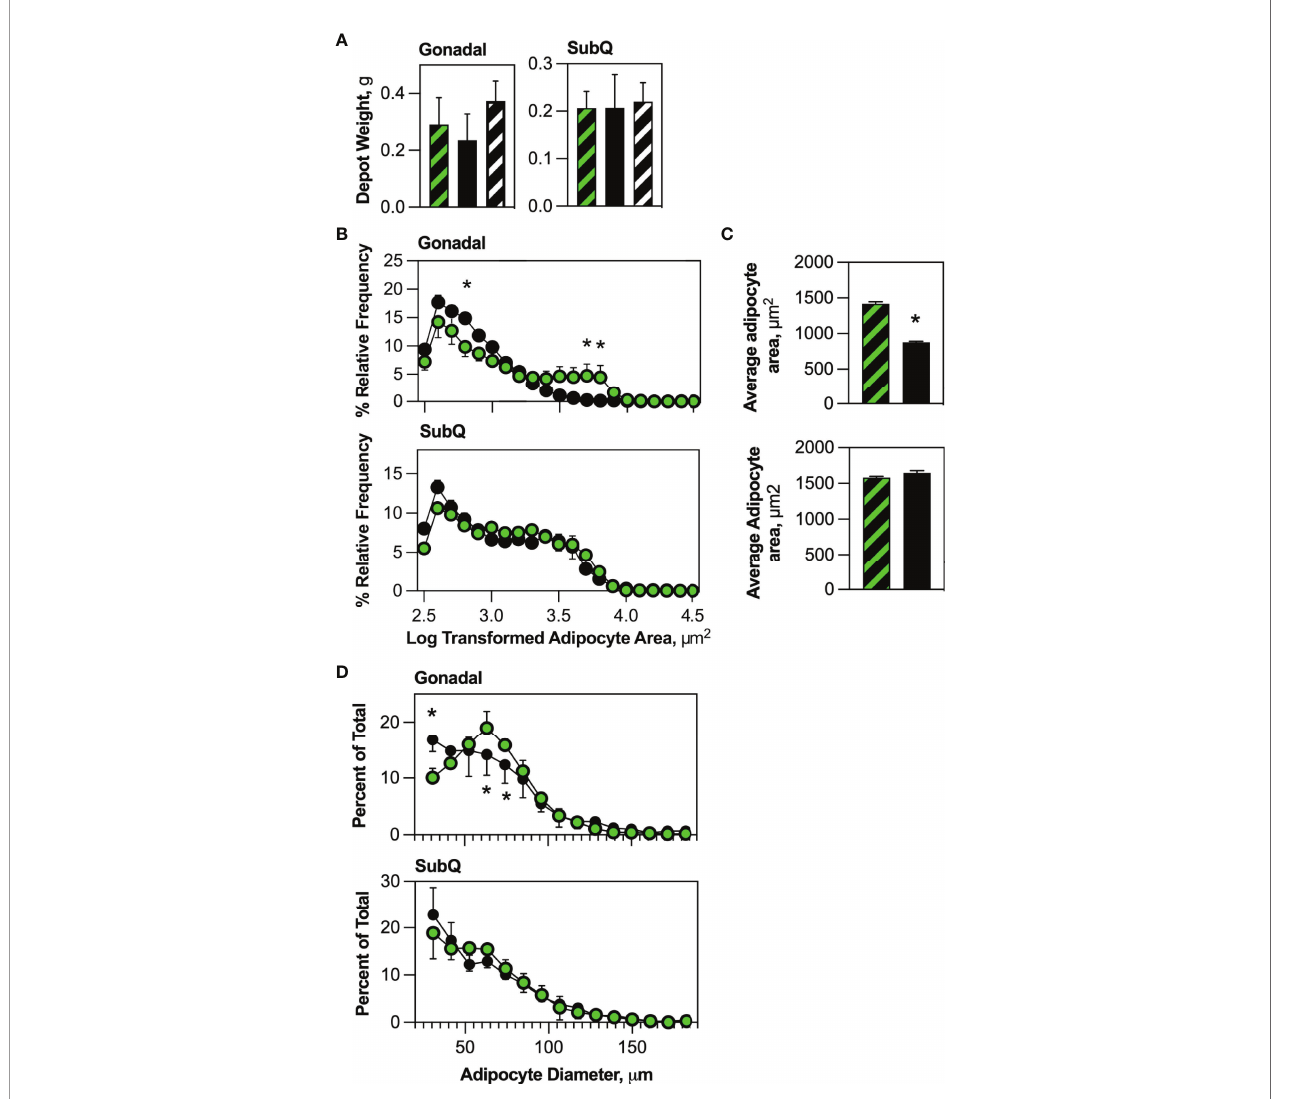
FIGURE 2 | HSCDA depletion did not affect adipose depot weights, but signi fi cantly reduced adipocyte size. (A) The weight of gonadal and subcutaneous (SubQ) fat pads in transplant-naïve, Competent (black/green crosshatch bars) and Ablated (solid black bars) mice were measured at the end of the experimental regimen. (n=8 per cohort) (B) Gonadal and subcutaneous (SubQ) fat was removed from Competent (black/green circles) and Ablated (black circles) mice, paraformaldehyde fi xed paraf fi n embedded tissue sections were prepared and stained with H&E. Adipocyte size was quanti fi ed with 10x phase contrast images captured and analyzed with the AdipoSoft plugin in FIJI software. The Log of adipocyte area versus frequency distributions are displayed. (n=8 per cohort, * indicates p ≤ 0.05) (C) Adipocyte area was quanti fi ed and the average for the entire Competent (black/green circles) and Ablated (black circles ) is shown. (n=8 per cohort, * indicates p ≤ 0.05) (D) Adipocytes from gonadal and subcutaneous (SubQ) adipose depots from Competent (black/green circles) and Ablated (black circles) mice were isolated from tissue by collagenase digestion into single cell suspensions. Dilutions of the adipocytes were immediately counted with a Cellometer Vision imaging cytometer, and the diameter of individual adipocytes measured under bright fi eld conditions was plotted. (n=8 per cohort, * indicates p ≤